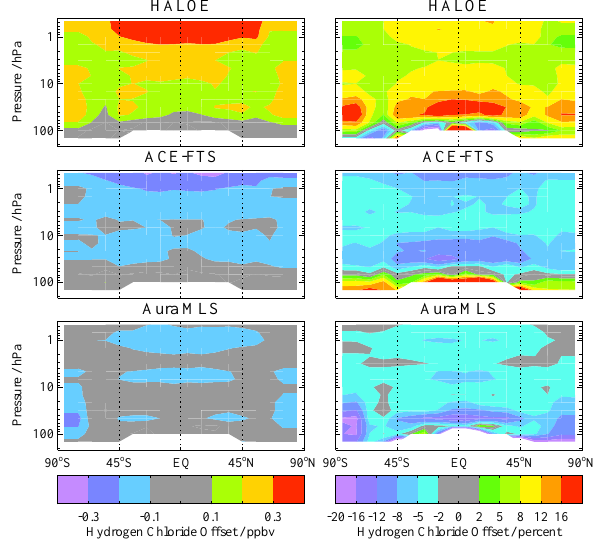
Figure 2. Offsets applied to the HCl source data sets (top panels for HALOE, middle panels for ACE-FTS, bottom panels for Aura MLS) as a function of latitude and pressure. The left column gives offsets in ppbv and the right column provides offsets as a percent of the zonal average merged mixing ratios during the overlap period (August 2004–November 2005) used here to compute the average